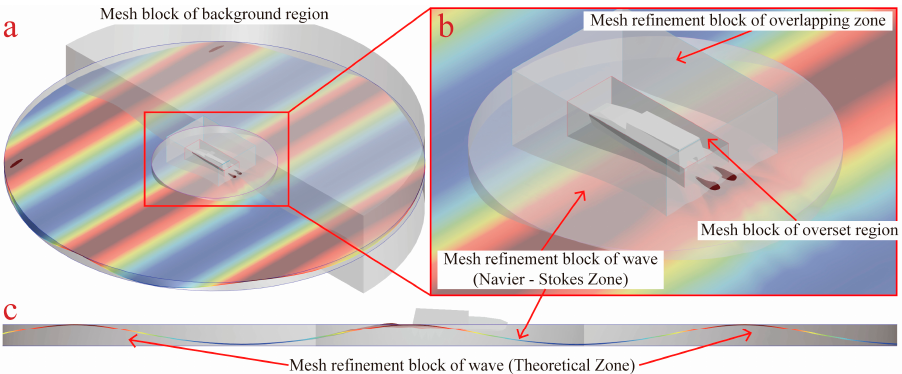
Figure 4. Mesh refinement blocks of computational domain: ( a ) mesh block of background region, ( b ) mesh refinement block of the overlapping zone and overset region, ( c ) mesh refinement block in the free surface wave zone.